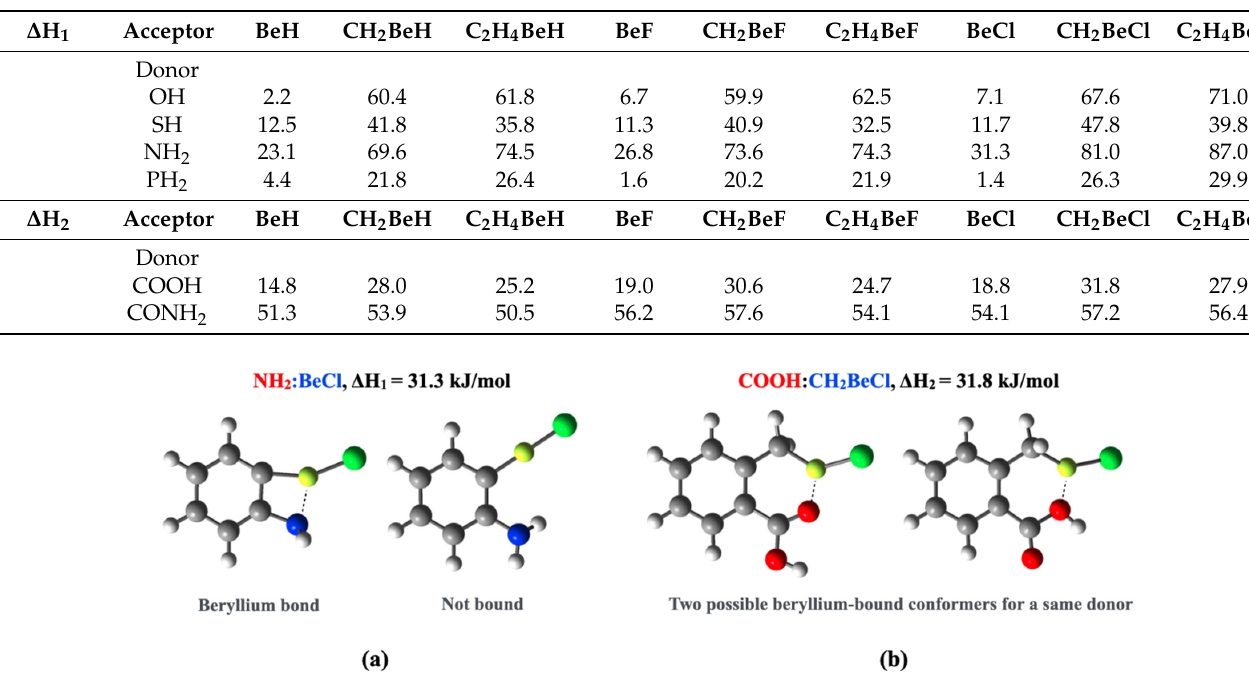
Table 1. M06-2X/6-311+G(d,p)//M06-2X/6-31+G(d,p) relative enthalpies ∆ H 1 (kJ · mol − 1 ) between the beryllium bound conformer and the most stable non-bound conformer, taking the beryllium bound conformer as zero. At the bottom of the table and for substituents COOH and CONH 2 , the enthalpy difference, ∆ H 2 (kJ · mol − 1 ), between the two possible conformers exhibiting a beryllium bond, the one involving the carbonyl group (systematically the most stable) and the one involving the OH (NH 2 ) group, is given.